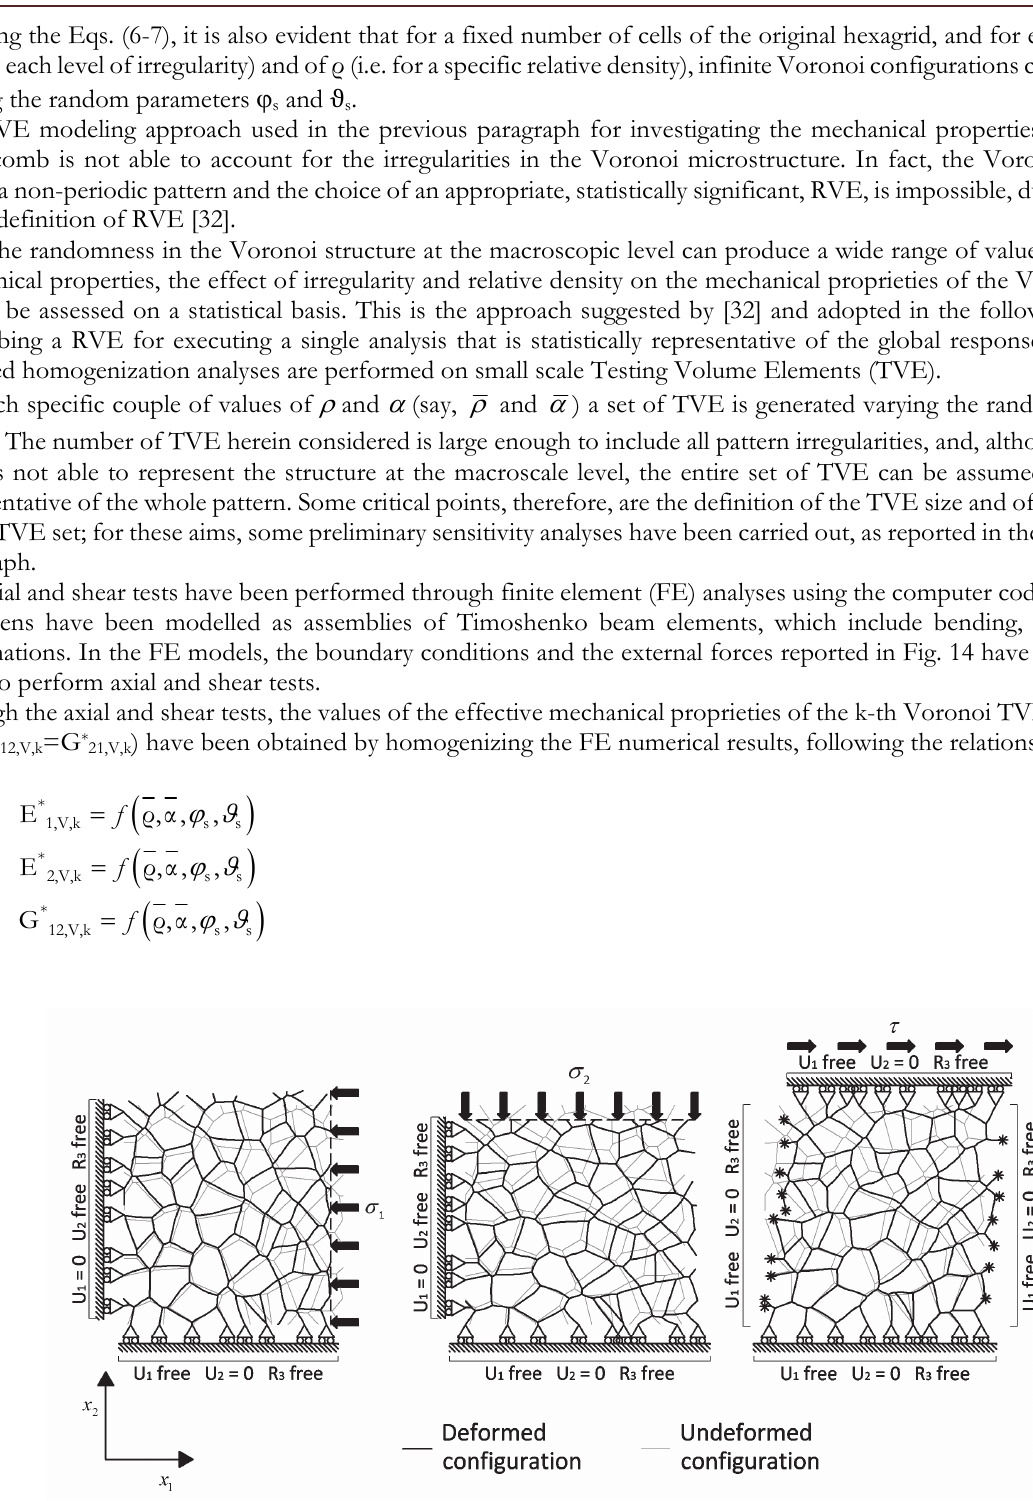
Figure 14: Boundary conditions and external forces adopted in the FE models of the Voronoi specimens. The ratio of the experimental values E * 1,V,k , E * 2,V,k and G * 12,V,k =G * 21,V,k , to the original hexagrid counterparts, resulting from of Eq. (17), and Eqs. (14-15), have been computed and appointed as the modification factors of axial and shear stiffness for the k-th TVE, η E1,k , η E2,k and η G12,k = η G21,k ,